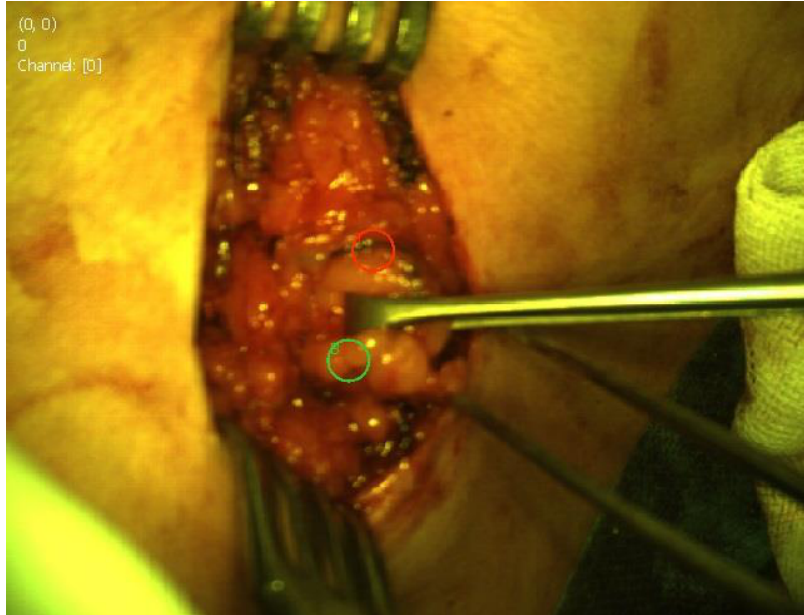
Figure 1. Sentinel node biopsy visible under normal light.